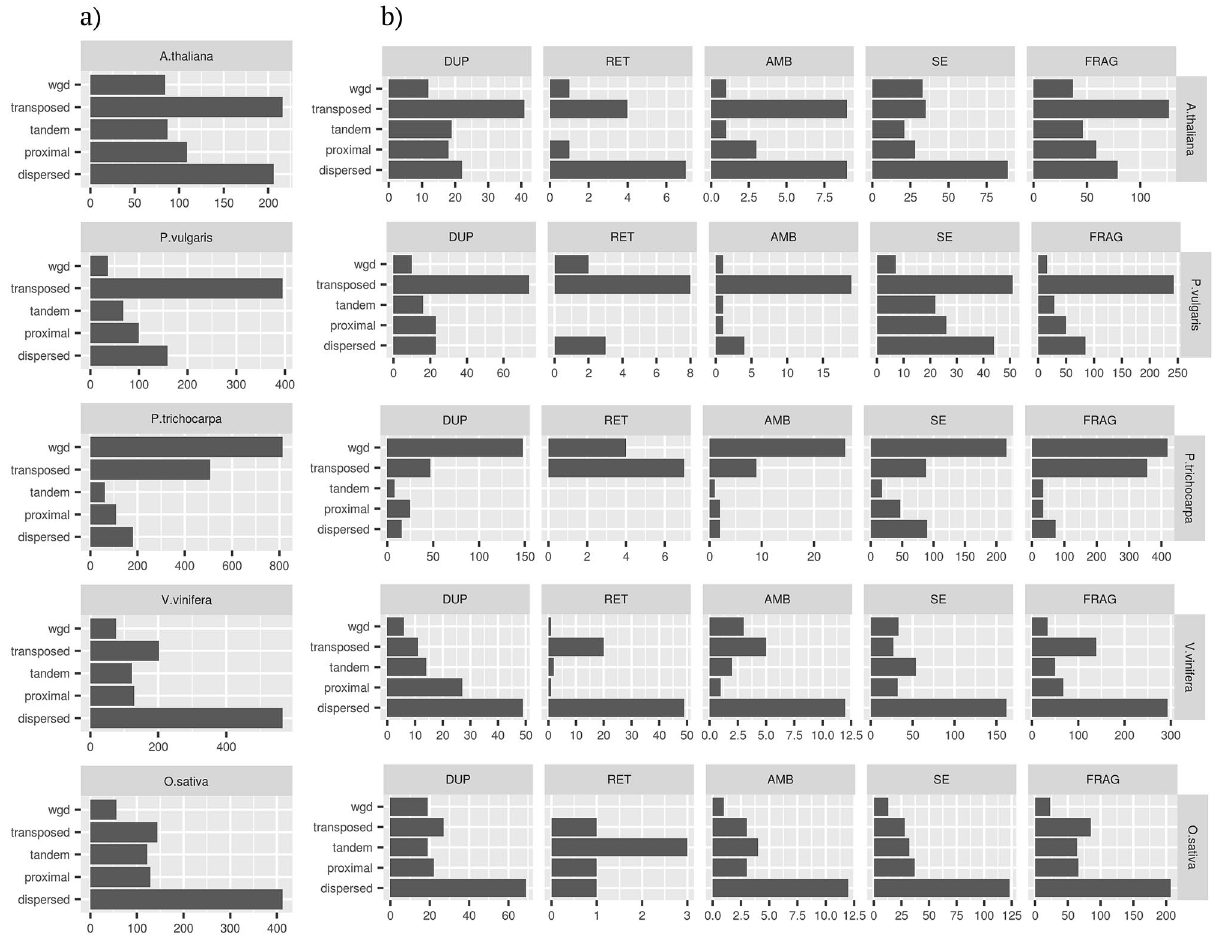
Figure 5. Pseudogene classification based on both intron exon structure and duplication modes in the five analyzed species. ( a ) Classification based on the duplication mode only. ( b ) Classification based on both duplication mode and intron exon